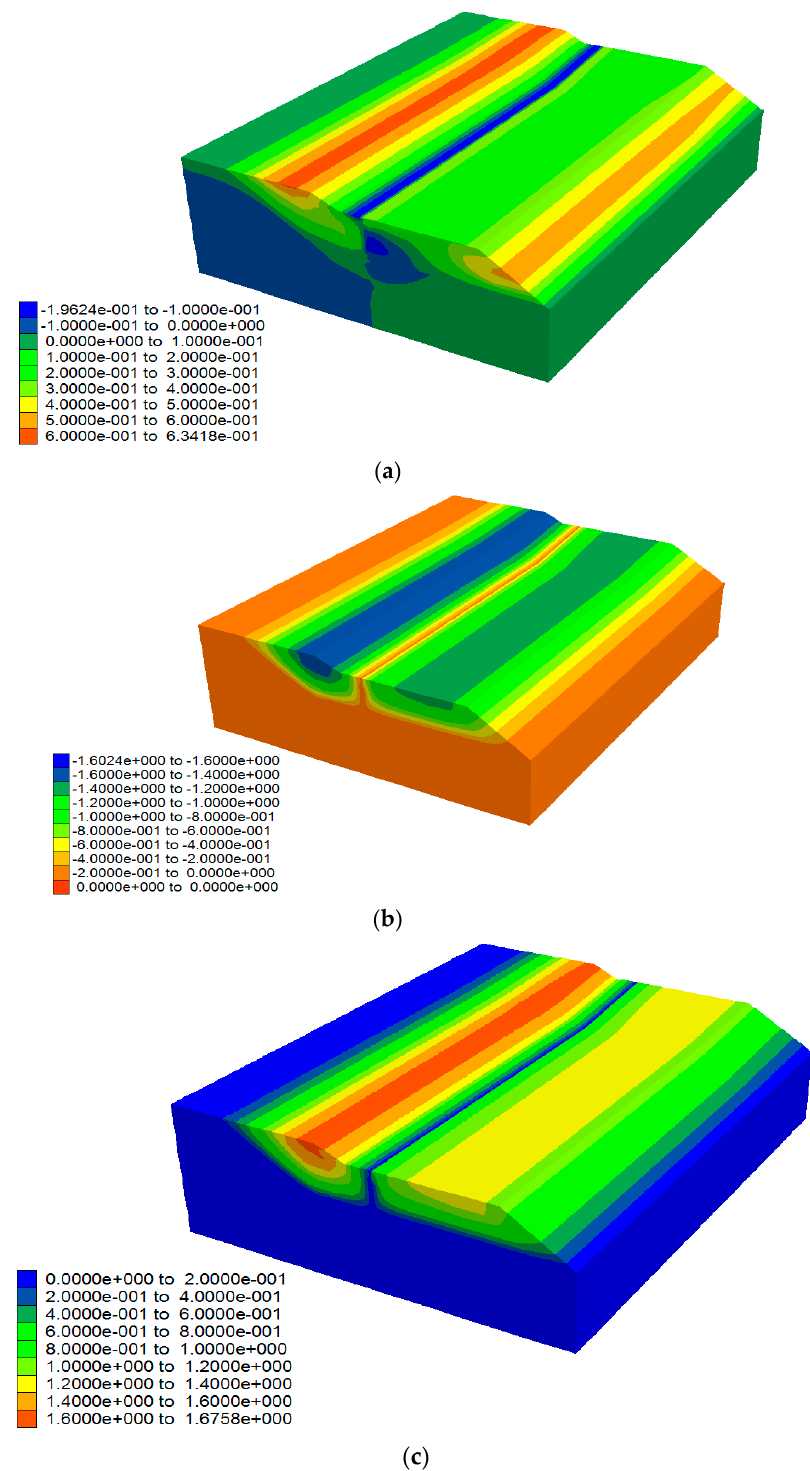
Figure 6. Cloud map of deformation law in analysis area of cut-off wall. ( a )Analysis Domain Hori- zontal Displacement Contour. ( b )Analysis domain vertical displacement cloud map. ( c ) Analyzing Domain and Displacement Contour.